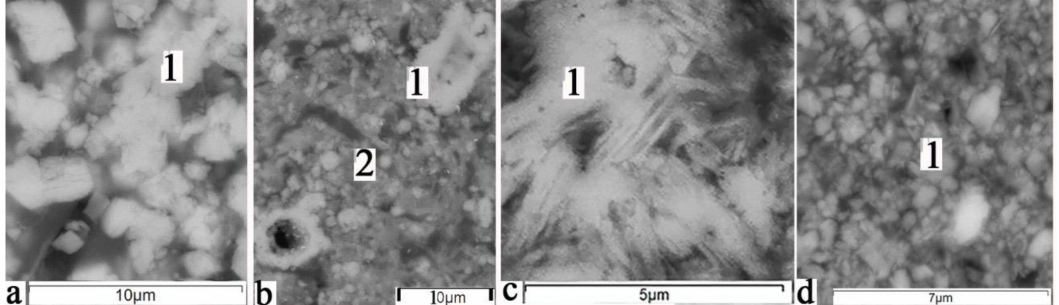
Figure 9. Microphotographs of authigenic carbonates at the water–bottom boundary. Ca-excess dolomite (a,b) and high-magnesium calcite (c,d): ( a ) Rhombohedral crystals of various sizes (Lake Tanatar—4), 1—Ca-excess dolomite; ( b ) 1—fouling of thin rhombohedral crystals of Ca-excess dolomite around terrigenous grains and mortmass, 2—grains of high-magnesium calcite (Lake Rublevo); ( c )—intergrowth of thin scalenohedral crystals of high-magnesium calcite (Lake Tanatar-6); ( d )—micrograins of high-magnesium calcite (Lake